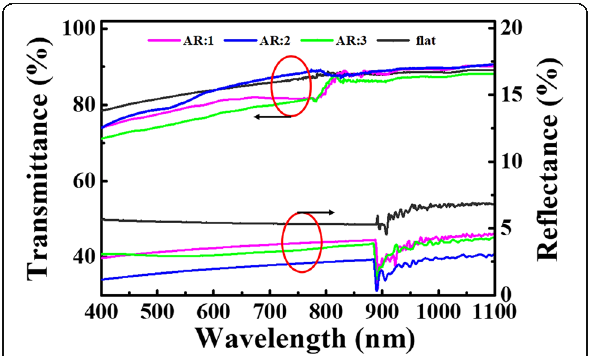
Fig. 4 The water contact angles of PDMS films with different aspect